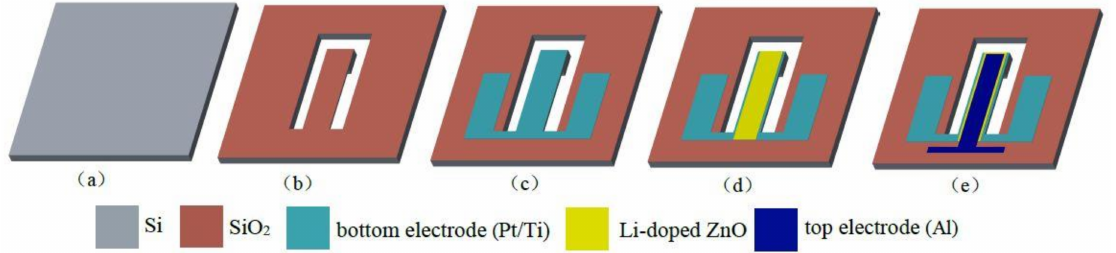
Figure 3. The main fabrication technology process of the proposed sensor: ( a ) the cleaning of the silicon wafer; ( b ) the releasing of the cantilever beam; ( c ) the growing of the Pt/Ti bottom electrode layer; ( d ) the sputtering of the Li-doped ZnO piezoelectric layer; ( e ) the evaporating the of Al top electrode layer.